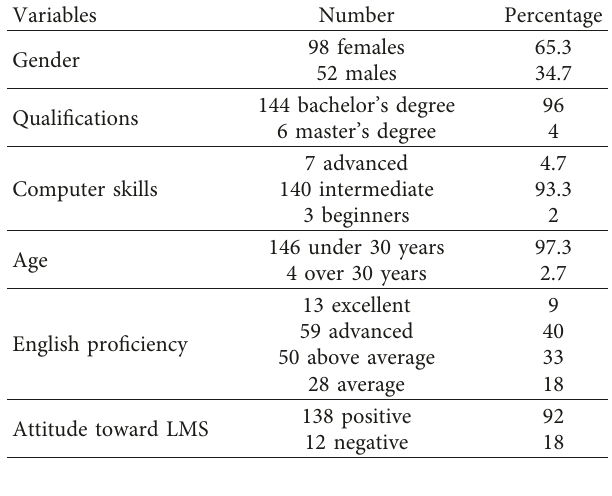
Table 1: Participant